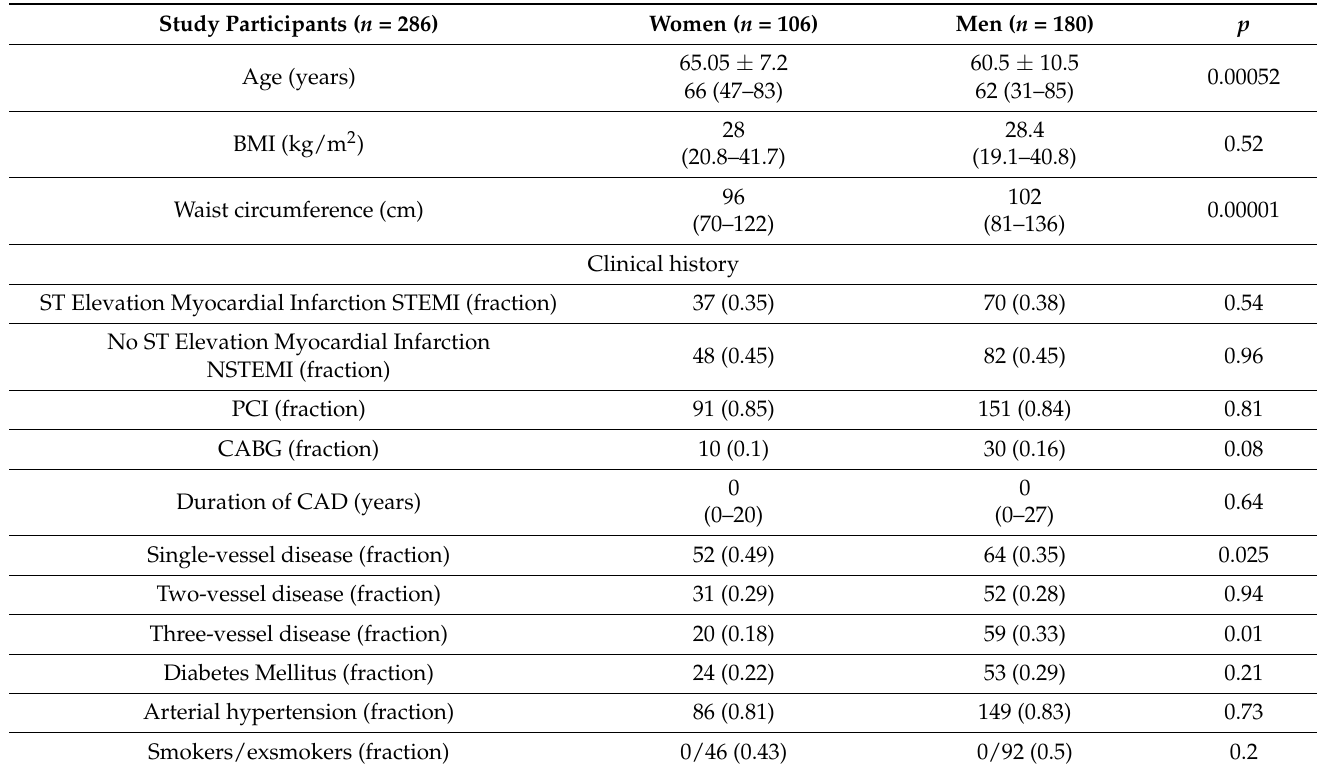
Table 1. Baseline anthropometric parameters, risk factors and clinical history of studied women and men with CAD before